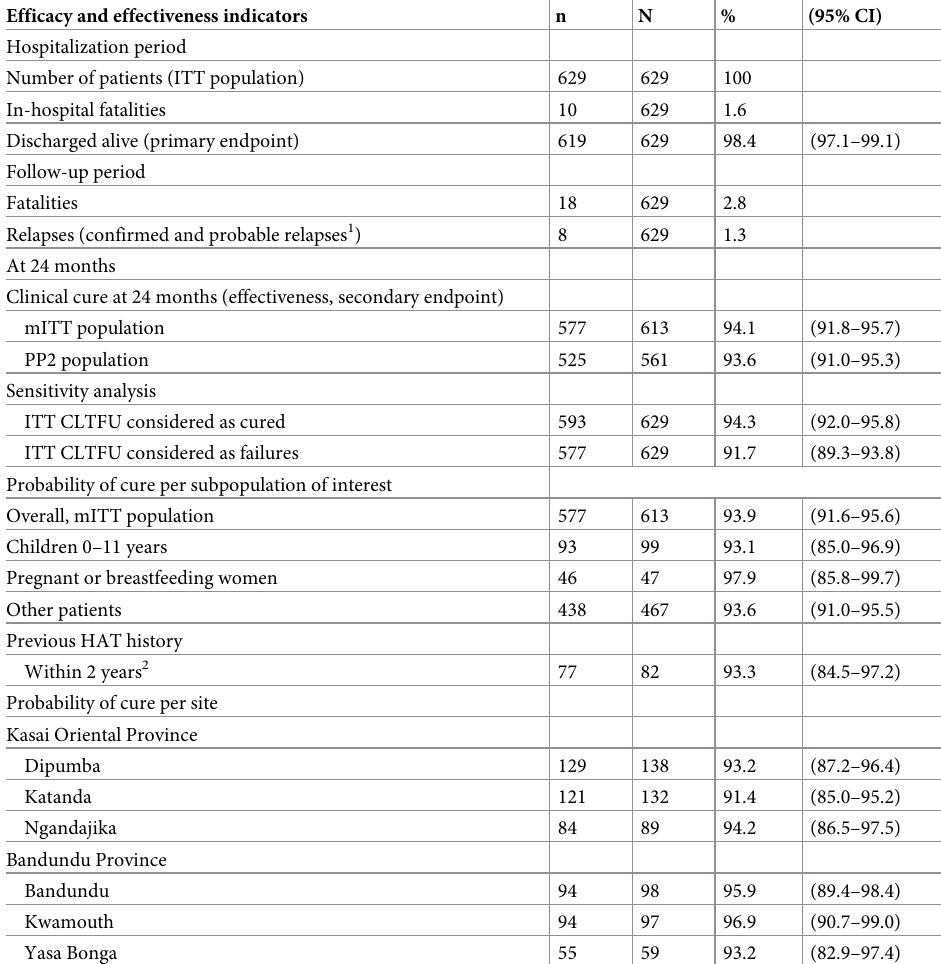
Table 2. Efficacy and effectiveness